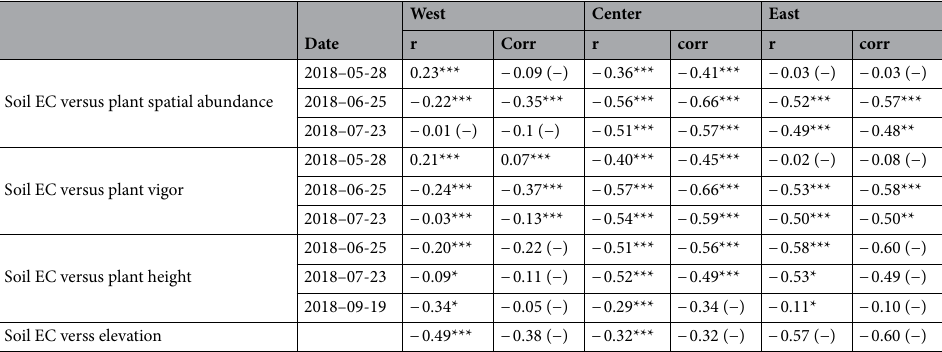
Table 2. Pearson’s (r) and corrected Pearson’s (corr) correlation coefficients computed between the average soil EC a , plant properties, and elevation. The table reports the correlations computed for the east, center, and west areas. Statistical significance is given by * p < .05, ** p < .01, *** p < .001, (−) for non significance.